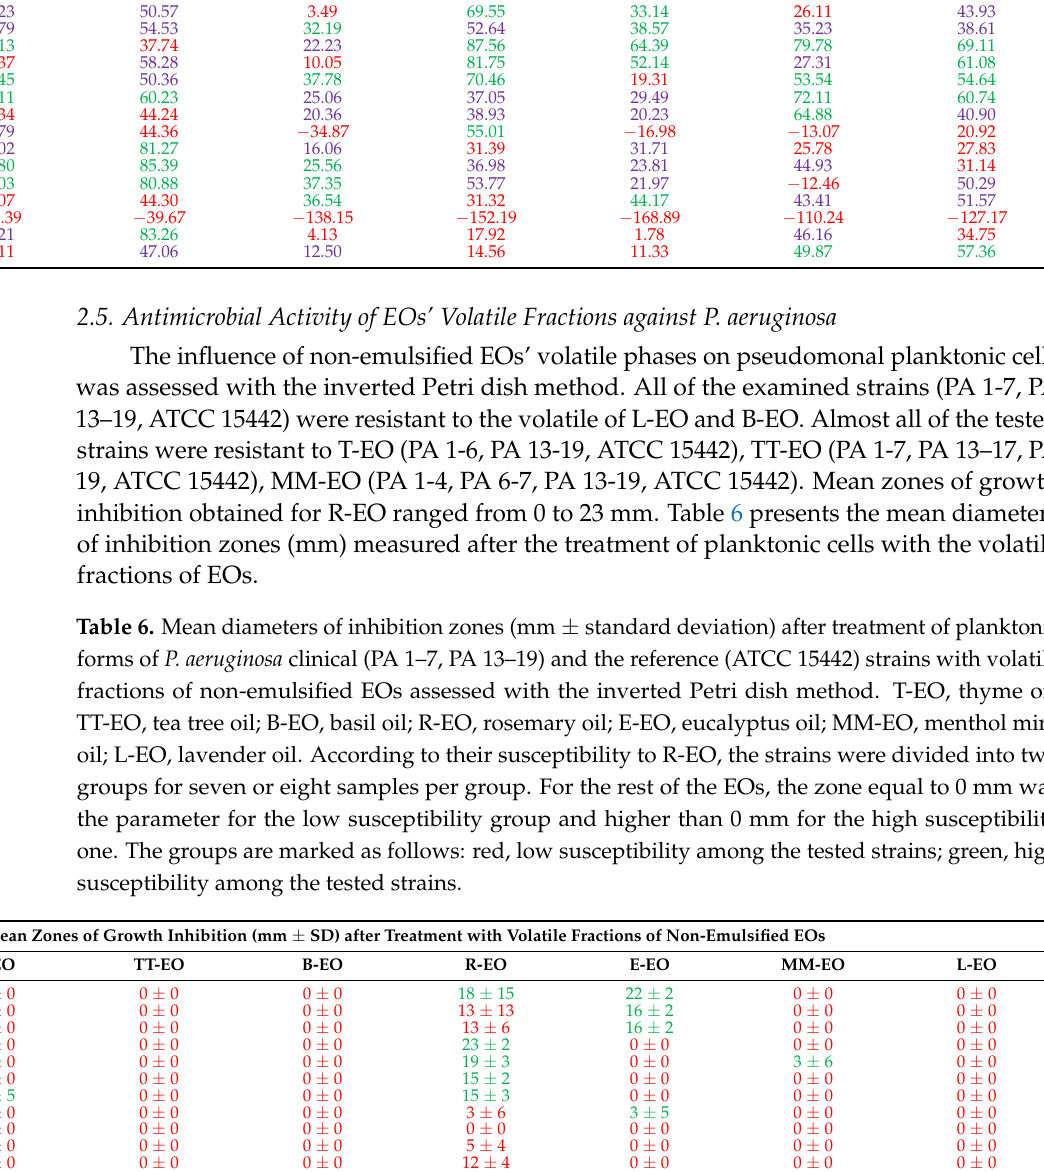
applied against the reference strain to prove the method’s usability. The mean obtained